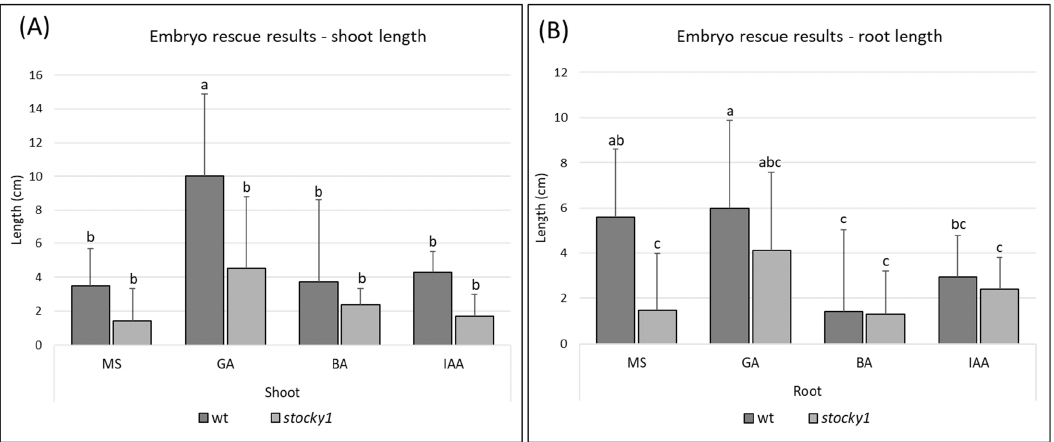
Figure 3. Effect of hormones on stocky1 growth in embryo-rescue experiment. Immature embryos were collected between 17 and 21 DAP, and were cultured for 10 days before taking root and shoot length measures. The embryos were cultured on MS media; hormones were added at a concentration of 10 − 5 M: ( A ) Graph showing the average length of WT and stocky1 seedlings shoot 10 days after culture (DAC). ( B ) Graph showing the average length of WT and stocky1 seedlings root 10 DAC. Error bars represent SD from biological replicates, WT ( n ≥ 30) and stocky1 (n ≥ 12). Different letters on top of SD indicate a statistically significant difference (P < 0.05) obtained with Tukey HSD test after one-way ANOVA.